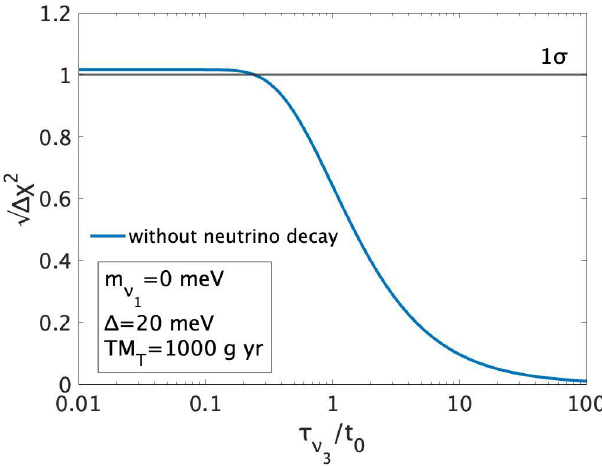
p ∆ Figure 7 . χ 2 as a function of a test value of τ ν where a fiducial value of ˆ τ is assumed to be ∞ , suggested by the SM. An exposure of TM ν 3 g yr and an energy resolution of ∆ = 20 meV are also assumed.